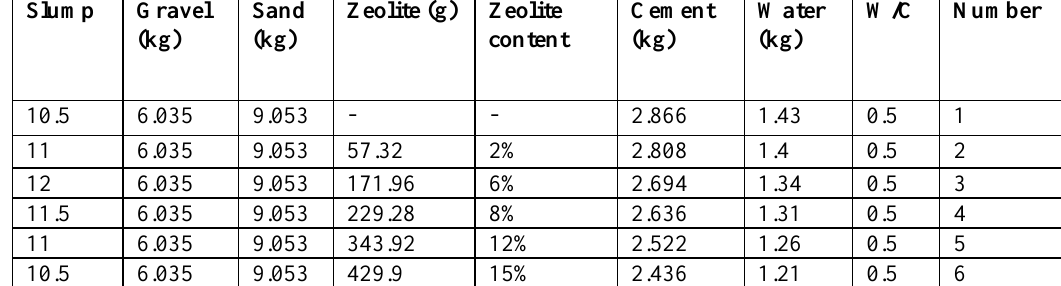
Component values of 340 kg / m 3 concrete mixes studied.